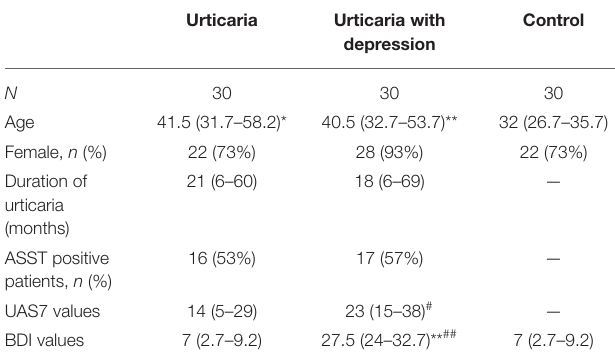
TABLE 1 | Demographic characteristics of the patients and